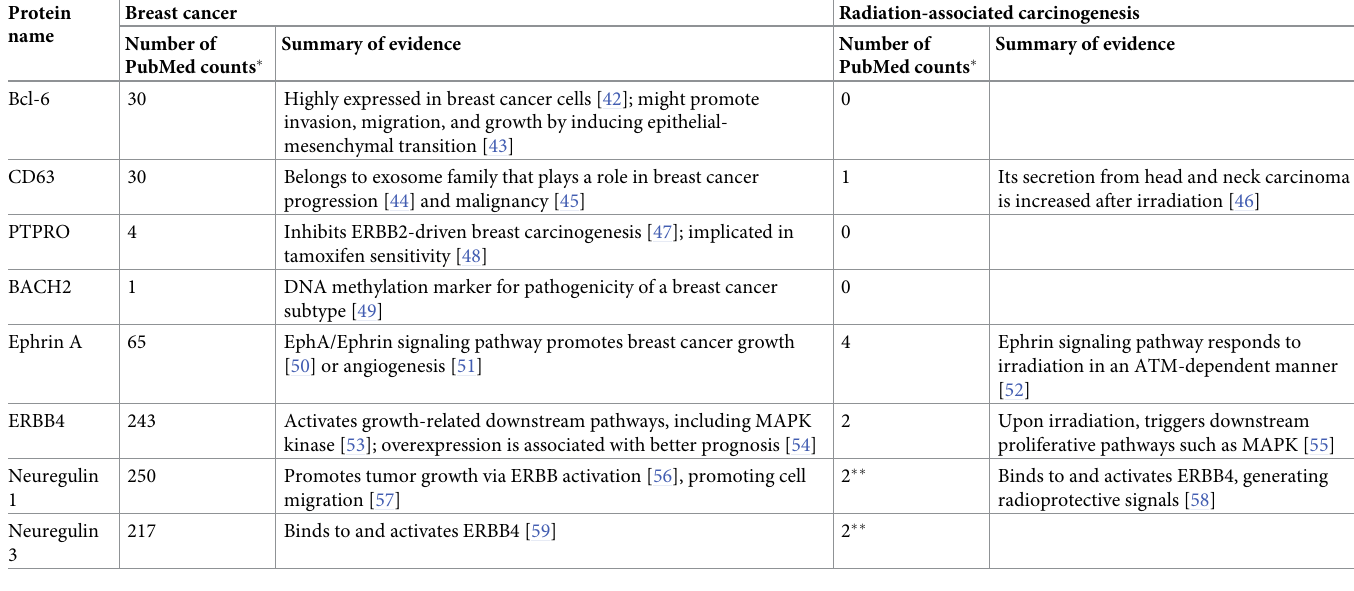
Table 3. Summary of literature survey on relevance of the genes/proteins in the protein-protein interaction network to breast cancer or radiation-associated carcinogenesis. Protein Breast name